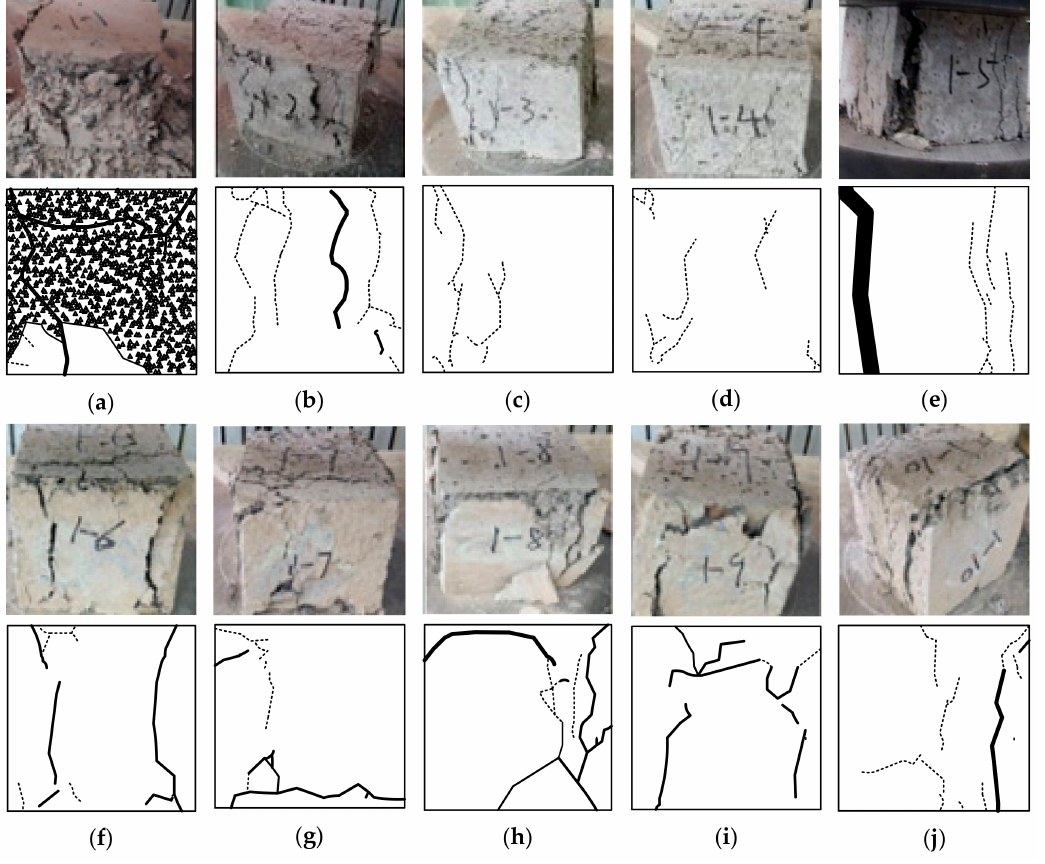
Figure 10. Failure types of specimens under compression: ( a ) C -J , ( b ) C a-10 , ( c ) C a-20 , ( d ) C a-30 , ( e ) C b-10 , ( f ) C b-20 , ( g ) C b-30 , ( h ) C c-10 , ( i ) C c-20 , and ( j ) C c-30